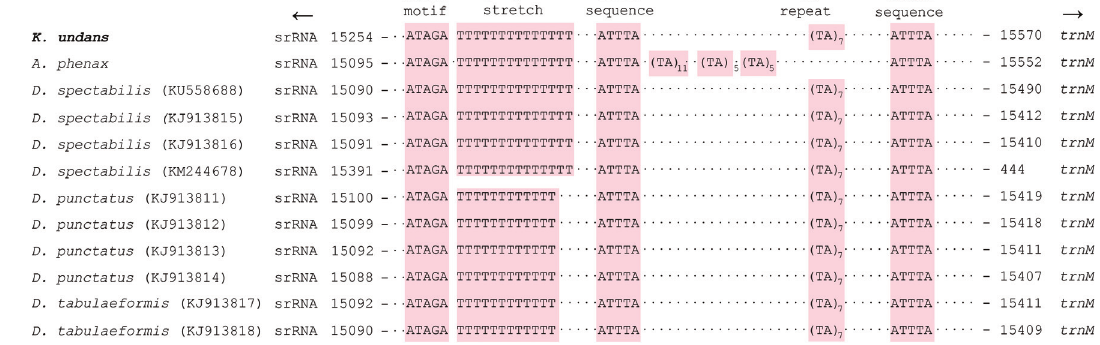
Figure 2 - Schematic illustration of the A+T-rich region of Lasiocampoidea, including Kunugia undans . The colored nucleotides indicate conserved se- quences such as the ATAGA motif, poly-T stretch, ATTTA sequence, and microsatellite-like TA repeat sequences. Dots between sequences indicate omitted sequences, and arrows indicate the transcriptional direction. Subscripts indicate the repeat number. GenBank accession numbers of the species represented by more than one mitogenome sequence are enclosed in parentheses.